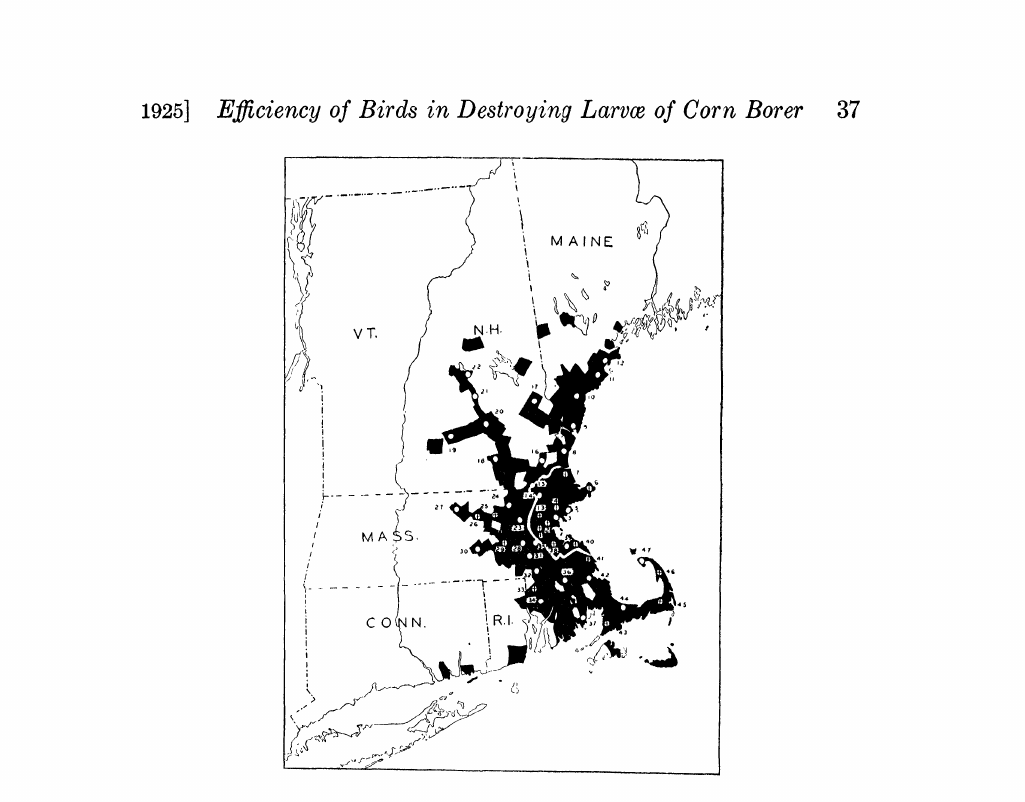
Fig. 2. Map of the area known to be infested by the European Corn Borer in New England in 1923. Circles show localities where experiments were placed in the fall of 1923 ;--clear circles indicate that no feeding by birds was found, while circles having a cross in the center indicate localities where birds fed on larvae contained in the corn stalks of the experiment. A white line surrounds the area known to be infested up to July 1, 1919. 1--Arlington,